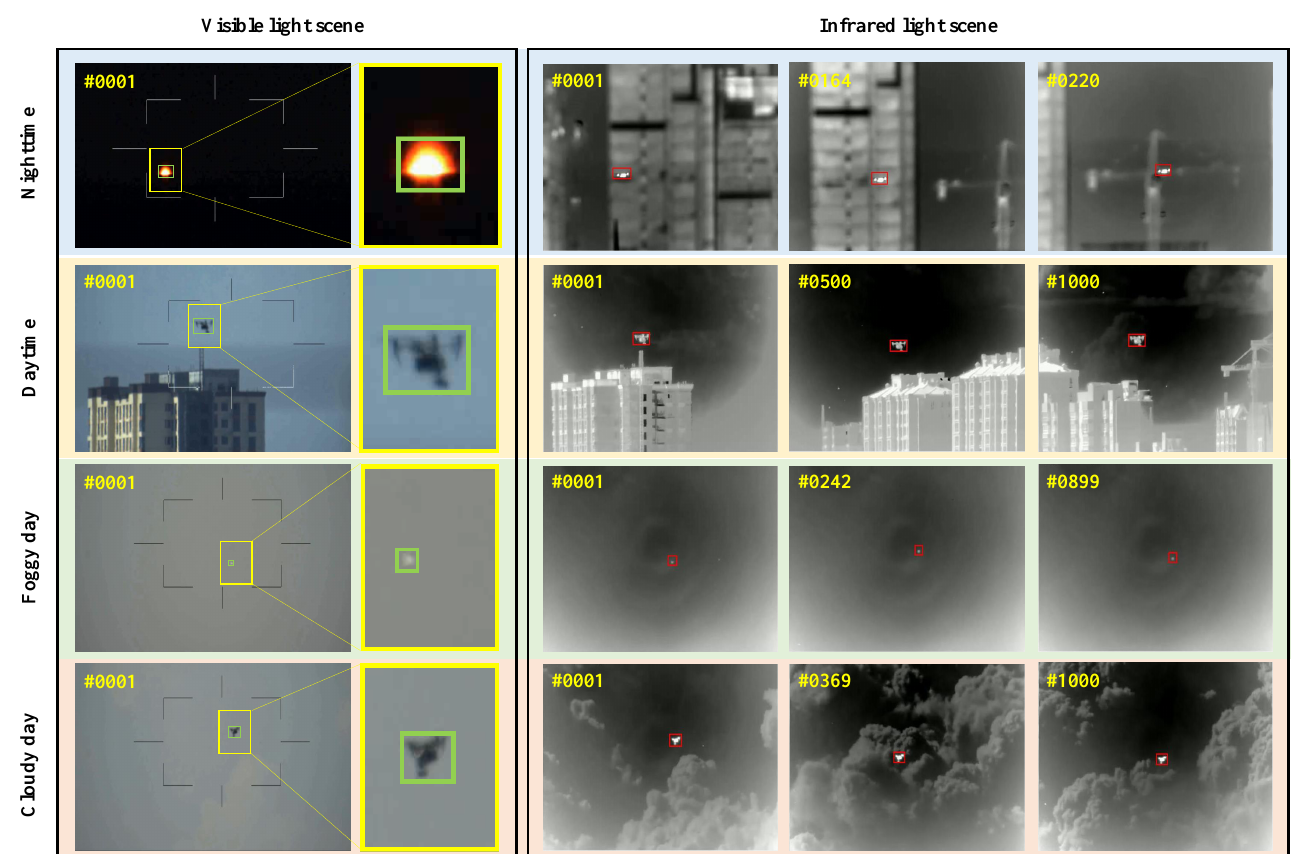
Figure 8. Visual analysis of SiamSTA for different weather challenges. From top to bottom are Sequence 20190926_195921_1_9, Sequence 20190925_101846_1_8, Sequence 20190925_133630_1_2, Sequence 20190925_131530_1_4. The red rectangle indicates the predicted results of SiamSTA.